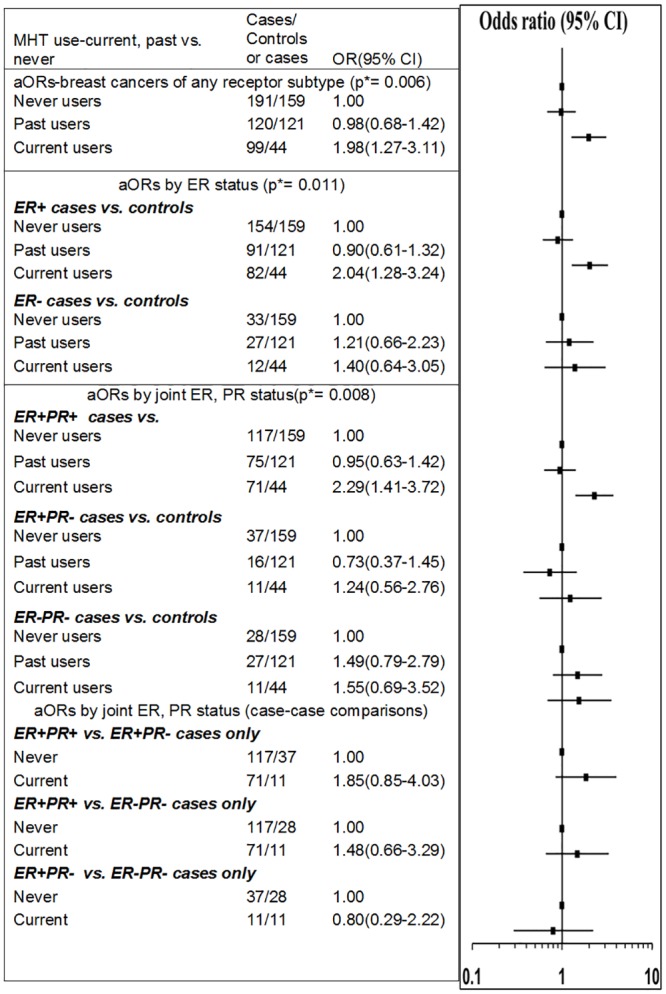
MHT use and invasive breast cancer risk by breast cancer hormone receptor (ER/PR) status.Legend: p* = p-value is for the test of global null hypothesis that the OR estimates are equal to one (i.e their reference group OR). Breast cancers with ER-/PR+ status (n = 6) were excluded from the analyses. All odds ratios were adjusted for age at index date, BMI, parity cross-classified by age at first birth, time since menopause, family history of breast cancer, place of residence, socioeconomic disadvantage quintile, oral contraceptive use, history of breast screening and alcohol consumption.